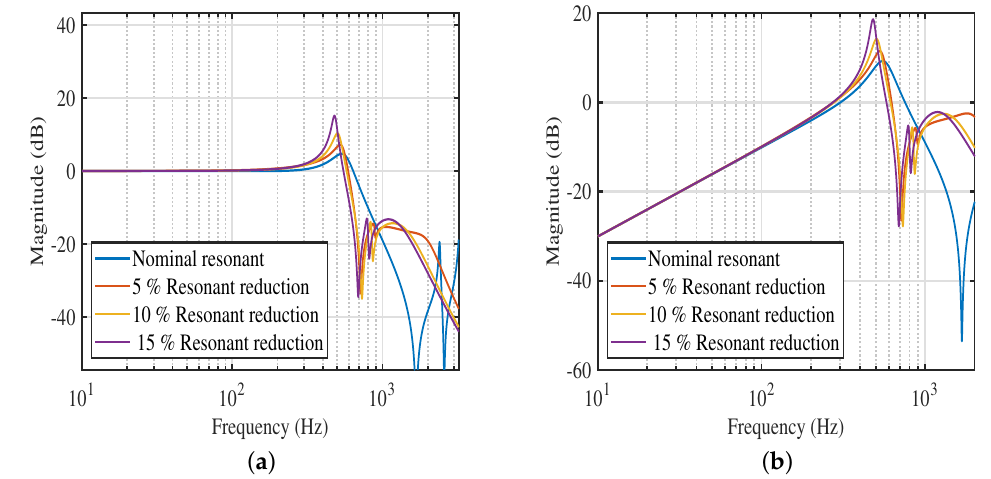
Figure 4. ( a ) Closed-loop magnitude response under resonant frequency changes for PVPF scheme; ( b ) Disturbance rejection profile for various resonant frequency changes for PVPF